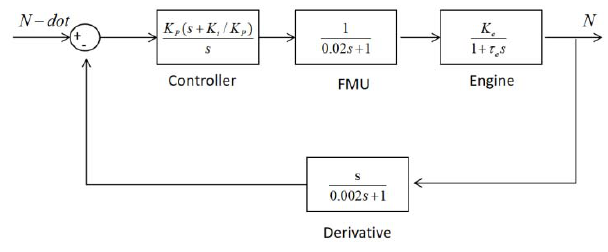
Figure 15. Block diagram for N ‐ Dot loop.